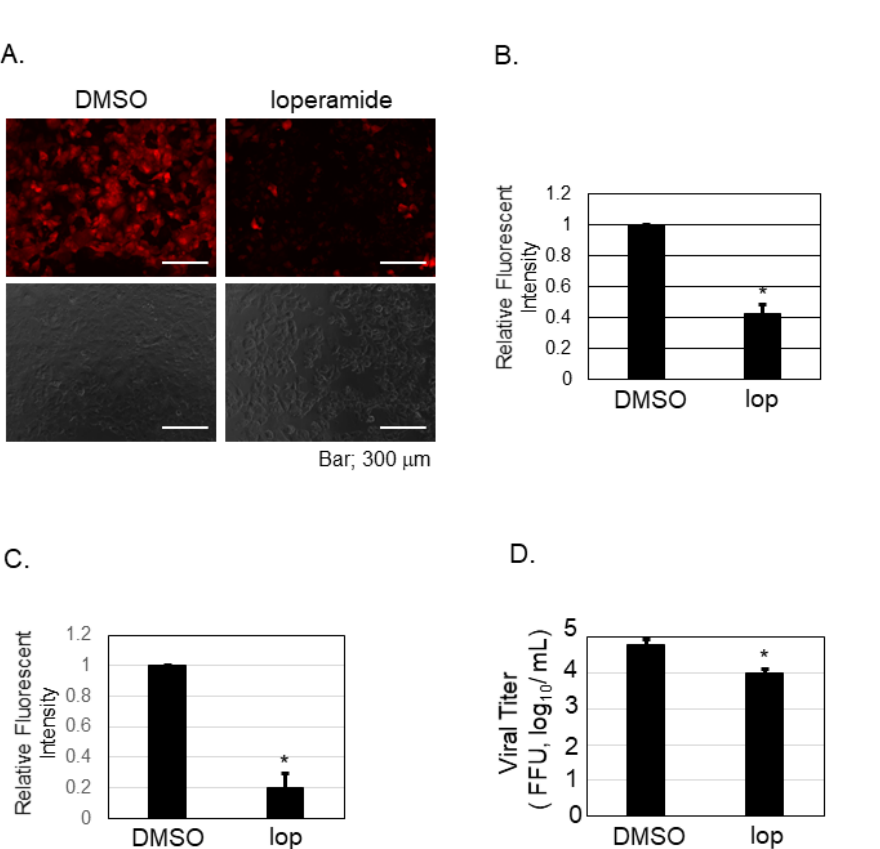
Figure 4. Calcium imaging and analysis upon loperamide treatment in Huh-7 cells. Huh-7 cells were treated with either DMSO or 10 μ M of loperamide (lop) and incubated for 48 h in the absence ( A , B ) or in the presence ( C , D ) of SFTSV. ( A ) Culture supernatant of Huh-7 cells was replaced with Rhod-4AM (10 μ M) diluted in Opti-MEM and incubated for further 20 min at 37 °C in 5% CO 2 . Fluorescent and bright field images of the fixed cells were captured. ( B ) Fluorescence intensity was measured and the relative mean ± SD ( * p < 0.05 ) is shown. ( C ) Same treatment described in ( A ), but infected with SFTSV (moi = 0.1), was performed. Fluorescence intensity was measured and the relative mean ± SD ( * p < 0.05 ) is shown. ( D ) The supernatant of the cells measured in ( C ) was collected to measure the viral titration. Data correspond to the mean ± SD (* p < 0.05).